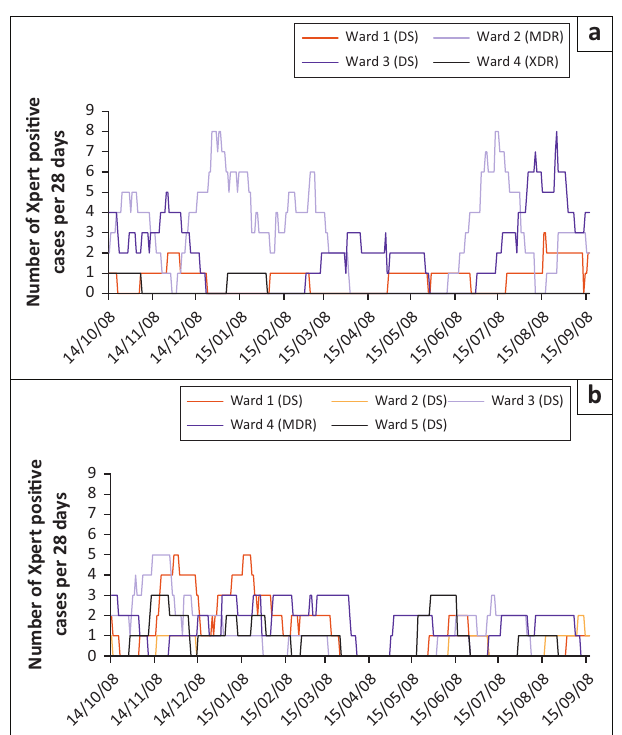
FIGURE 1: Detection of C. difficile in samples provided by patients attending Hospital A and Hospital B stratified by patient age. The relative proportions of samples provided by patients in Hospital A and Hospital B testing positive (+ve) and negative (-ve) by the Xpert® C. difficile test (Xpert), along with those that yielded an indeterminate or invalid result (Ind). Numbers above the columns represent total number of tests performed for each category.